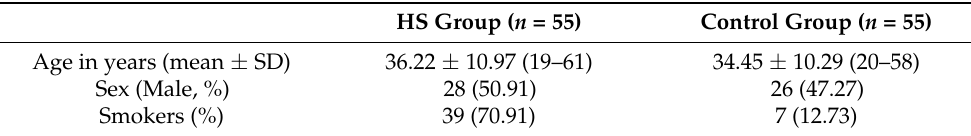
Table 1. Patients’